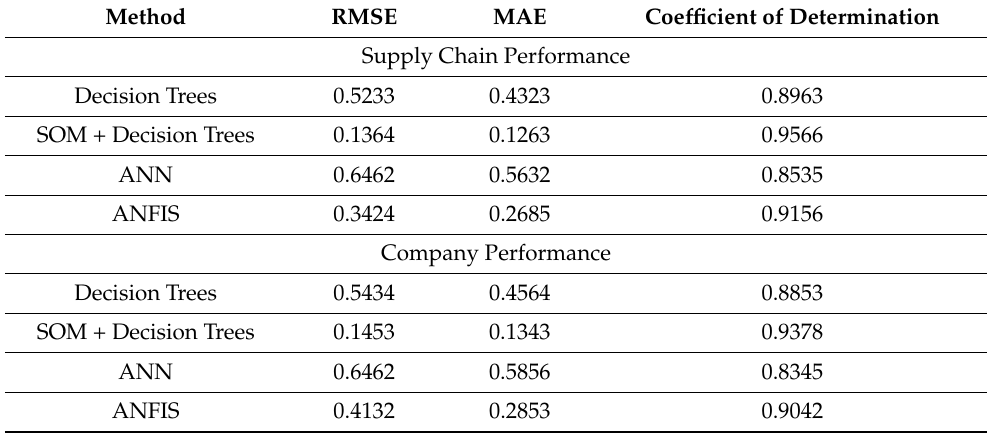
Table 10. Comparison of